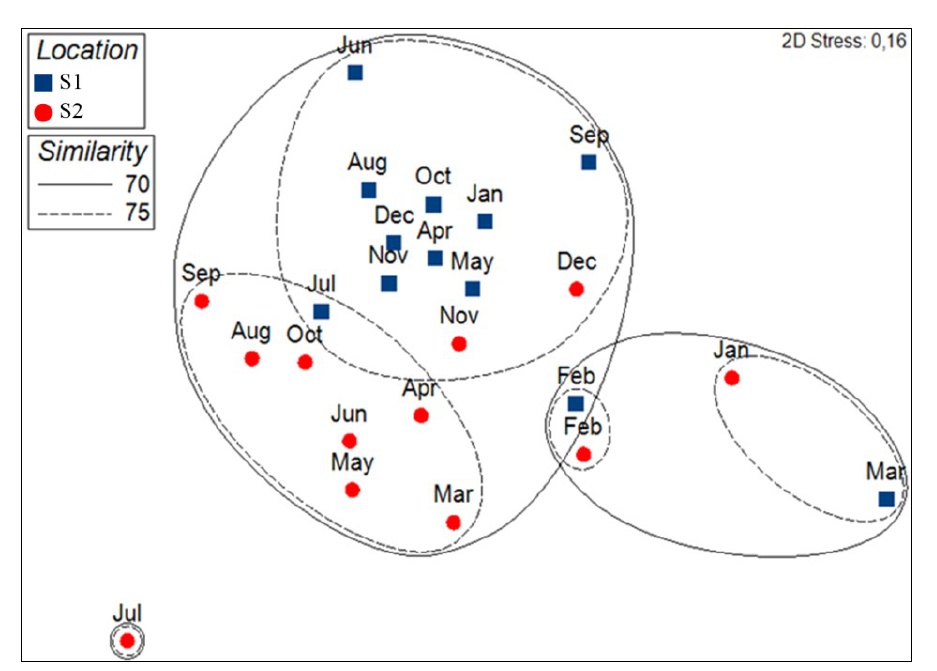
Figure 7. MDS of phytoplankton assemblages of Calvi (S1, in blue) and Bastia (S2, in red) coupled to a cluster analysis. Solid and dashed lines represent the principal clusters identified at respectively a 70% and 75% Bray Curtis